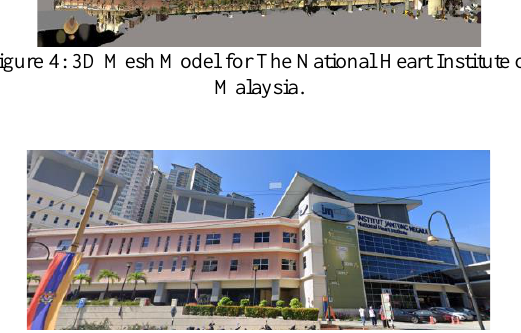
Figure 5: Image for The National Heart Institute of Malaysia, (Source: Google Maps)